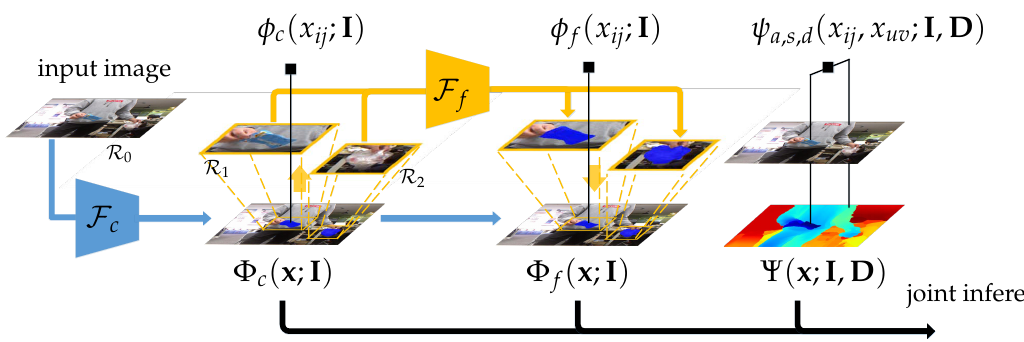
Figure 3. The graphical representation of our CRF. F c and F f represent the feature embedding functions for the coarse and the fine segmentation networks. Our model consists of the scene-level unary term Φ c ( x ; I ) , the object-level unary term Φ f ( x ; I ) , and the pixel-level pairwise term Ψ ( x ; I , D )